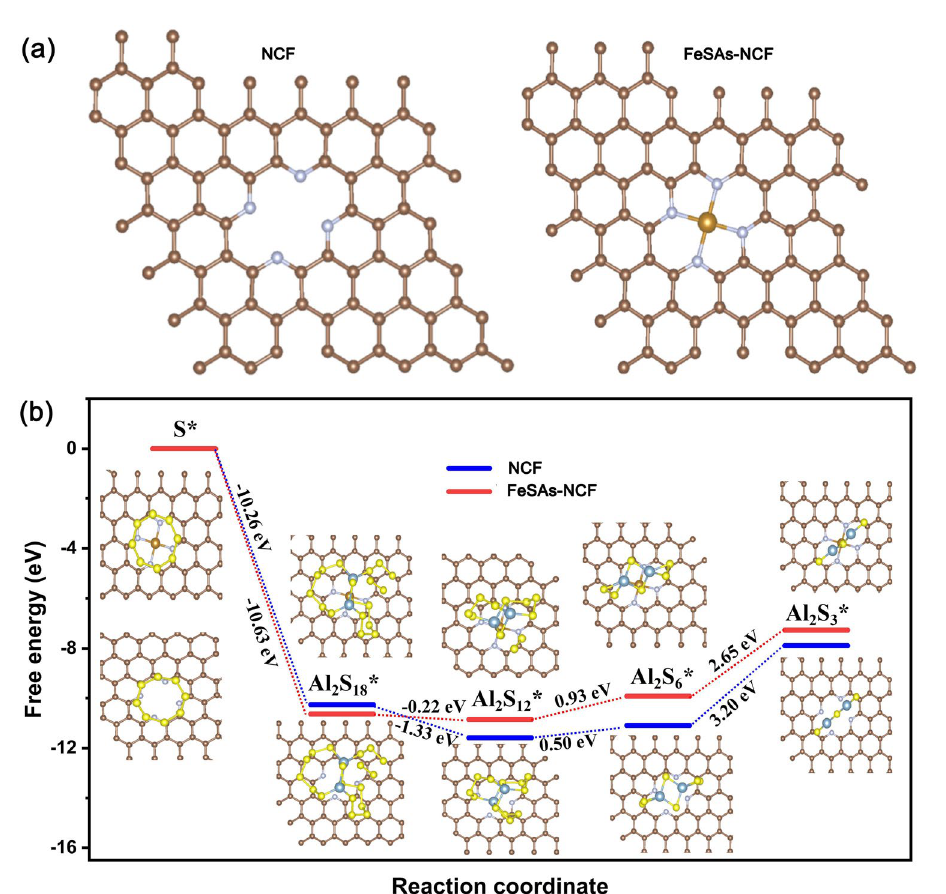
Fig. 5 a The optimized structure models of NCF and FeSAs-NCF and b Energy profiles for the reduction of sulfur to aluminum sulfides on NCF and